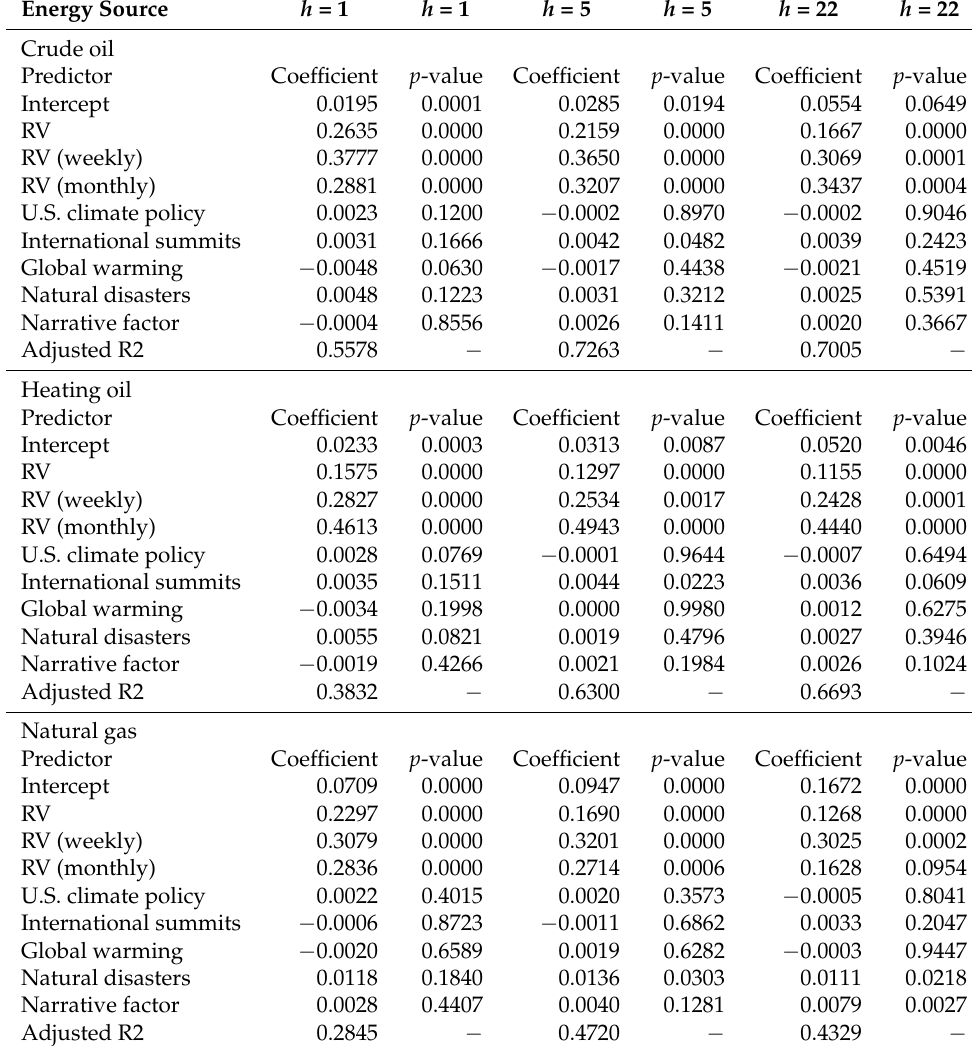
Table 1. Full-sample results. The p -values are based on robust heteroskedasticity and autocorrelation consistent standard errors. The parameter h denotes the forecast horizon (in